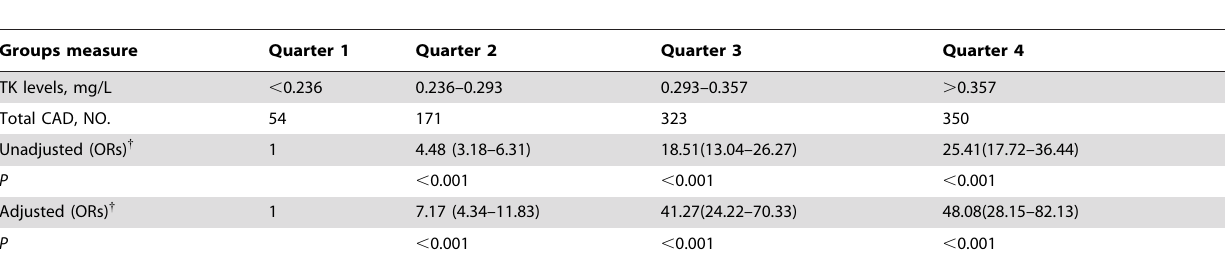
Table 3. Unconditional logistic regression analysis for CAD and TK